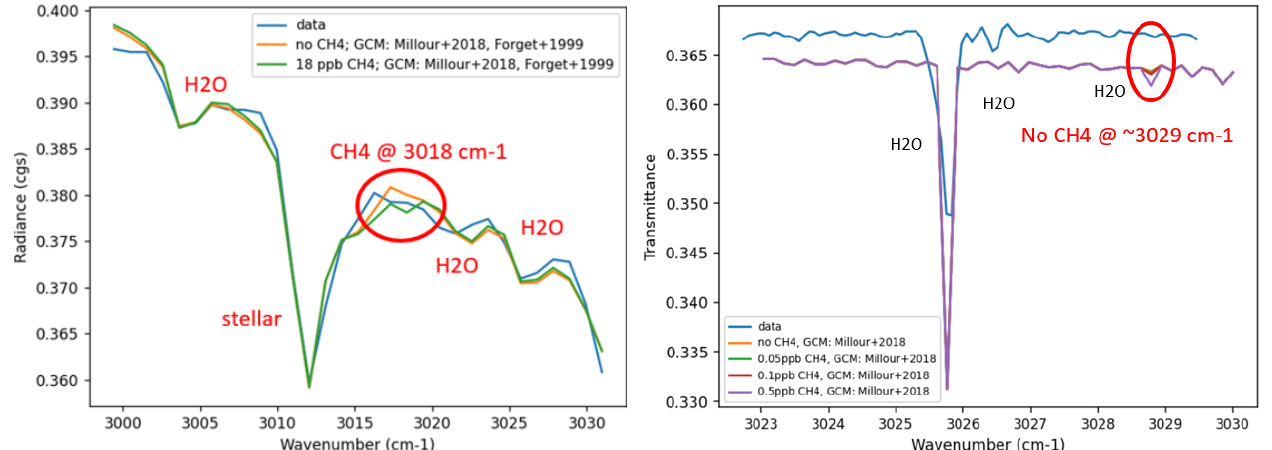
Figure 13. Comparison between best-fit simulations and data. ( Left panel ) Comparison between the simulation and MEx data [25]. Blue line: data. Orange line: MCD [61,62] with no methane. Green line: MCD with 18 ppb of methane. The red circle highlights the region where the methane absorption feature is present, both in the data and in the orange line. We chose 18 ppb of methane as a first educated guess for the abundance of methane following Giuranna et al. [25]. The simula- tion with no methane has a χ 2 / N ∼ 4.8 and the simulation with 18 ppb of methane has χ 2 / N ∼ 5.4. One stellar line and several water absorption features are identified (see Table 4 for the position of the absorption features); ( Right panel ) Comparison between the simulation and ExoMars data ([51]), at 3023–3030 cm − 1 . H 2 O absorption features are identified. Several abundances of methane were simulated, namely 0.05 ppb (green line), 0.1 ppb (red line) and 0.5 ppb (purple line). The upper limit derived by observations was 0.05 ppb [26]. For an abundance of 0.5 ppb, a methane opacity